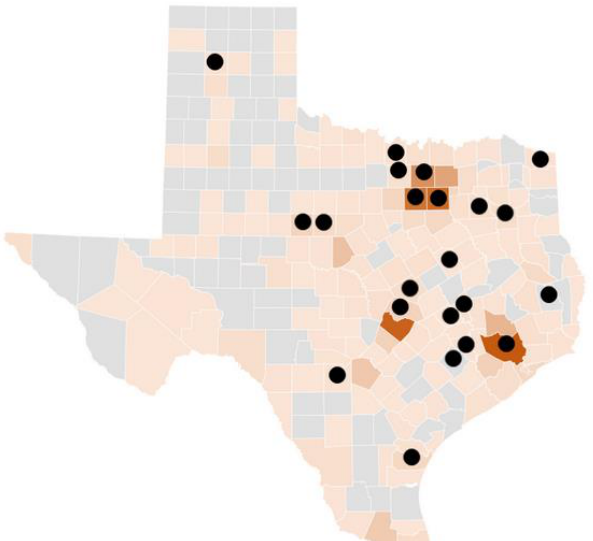
Figure 2. CDC human case reports from 2000 to 2018 with overlapping TTS respondent tick bite recall by counties in Texas.